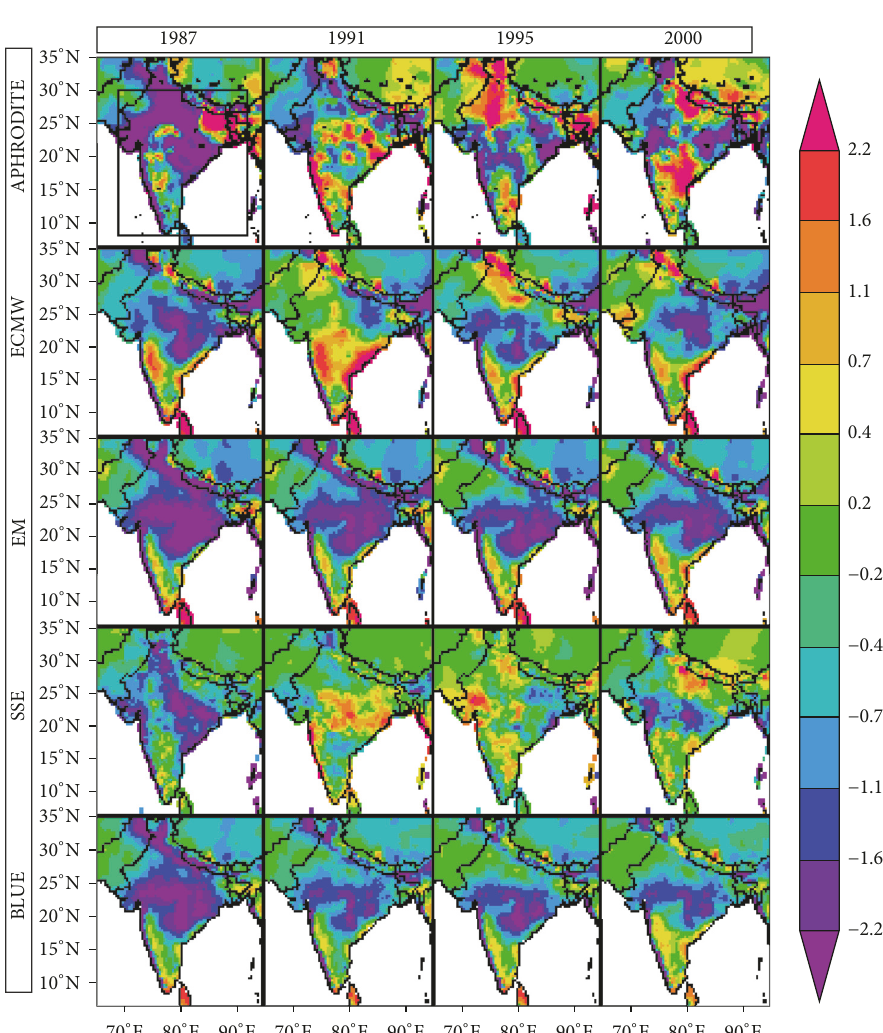
Figure 1: June to September rainfall anomalies (mm/day) for 1987, 1991, 1995, and 2000 from APHRODITE, ECMWF (abbreviated in caption as ECMW), EM, SE, and BLUE. A rectangular box (69–92E, 8–30) is shown in the first panel (top right corner). This is the target region of Figures 2 and 3.